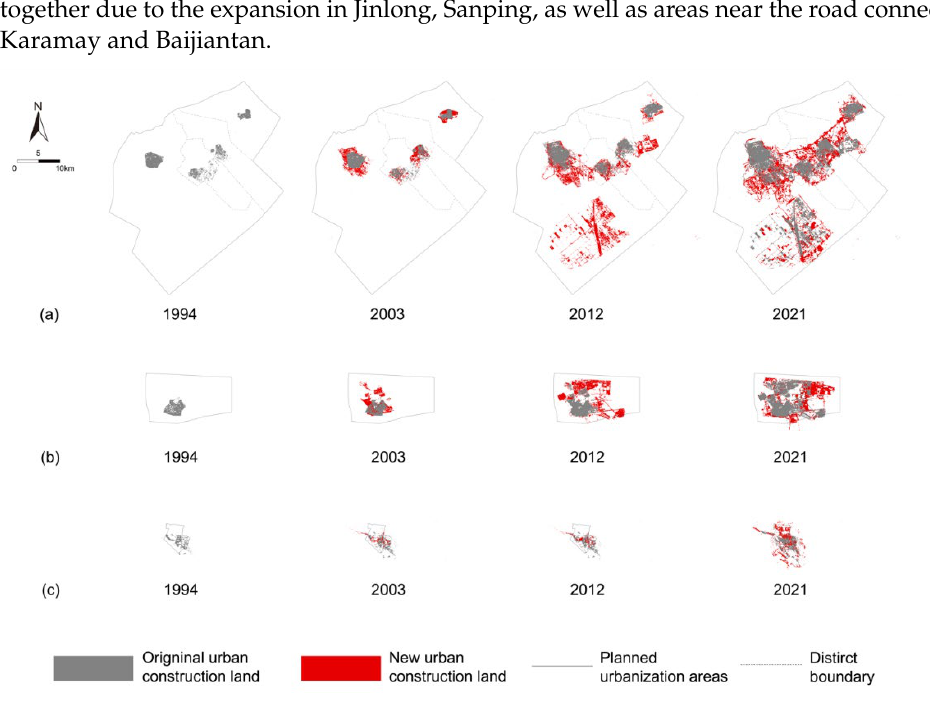
Figure 3. Spatial distribution of newly developed urban construction land from 1994 to 2021. ( a ) from left to right: Karamay, Jinlong, Sanping, and Baijiantan; ( b ) Dushanzi; ( c ) Wuerhe.